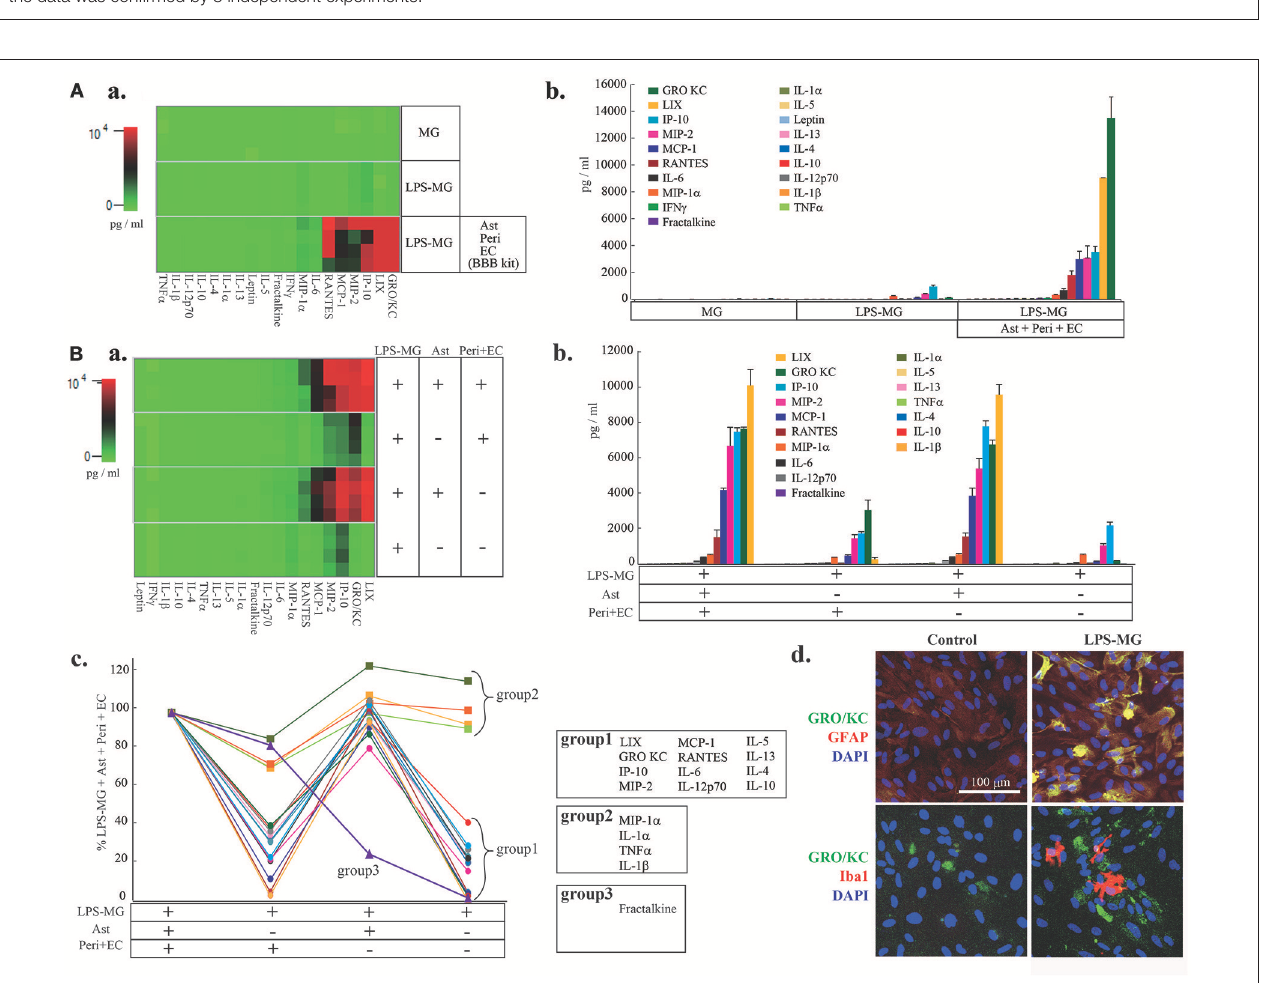
FIGURE 1 | and claudin5 (bottom) (e). Scale bar indicates 50 µ m. N = 4, * < 0.05 vs. control, ANOVA followed by Tukey’s test. Error bars represent the s.e.m. (C) Comprehensive quantitative measurement of C/C concentrations in the medium of the abluminal side of the BBB model one day after incubation with LPS-MG. (a) Heat map of the concentrations of all 27 C/Cs. (b) Concentrations and their fold changes. The fold change represents the C/C concentration ratio of LPS-MG + BBB to BBB alone. Asterisks indicate a significant increase compared to the BBB alone. N = 4, * < 0.05 vs. control, ANOVA followed by Tukey’s test. The reproducibility of the data was confirmed by 3 independent experiments.